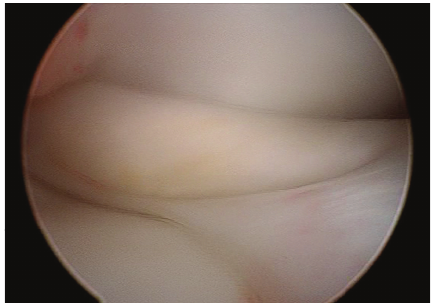
Figure 2: Arthroscopic image of the medial femorotibial compart- ment of the right knee from the anterolateral portal showing the upper side of the medial meniscus folded in the intercondylar